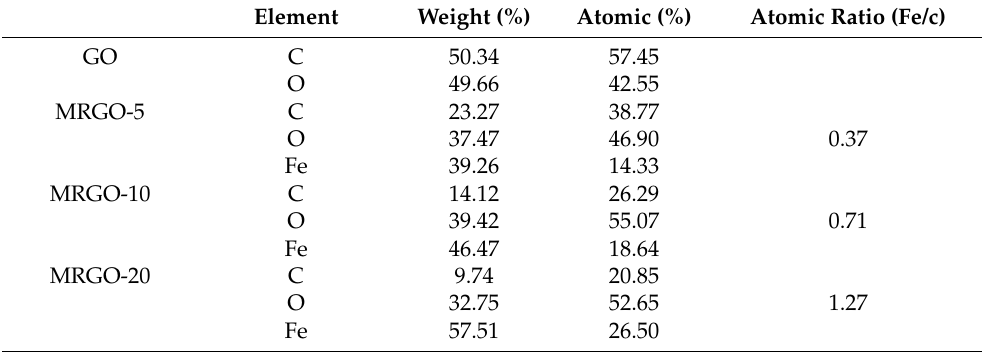
Table 3. EDX analysis of GO and MRGOs.